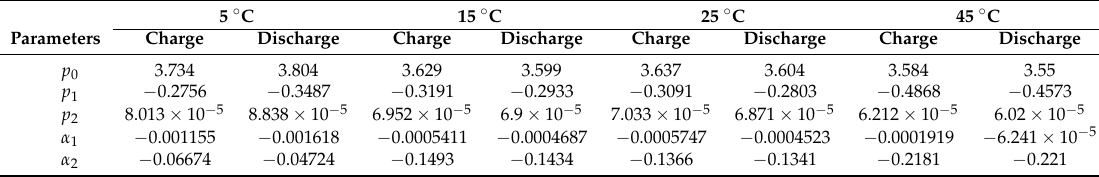
Table 7. Parameters of the proposed fitted OCV model at different temperatures.